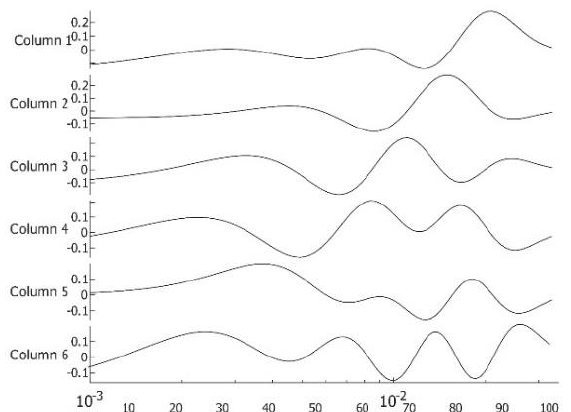
Figure 3. Amplitude of images 1 – 6 in Figure 2 over virtual time on log time scale with the sequence t i = 0.025 × 2 (i − 100 ) /20 . Traces 1–6 are time amplitudes of Figure 2A–F.